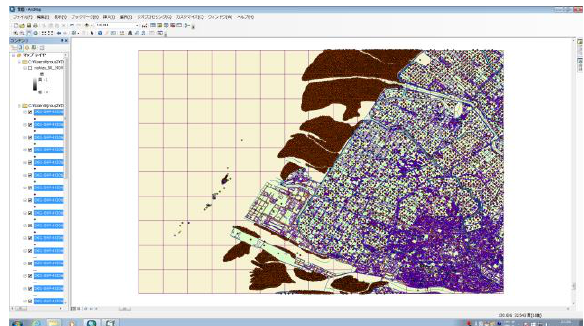
Figure 6. Digital Information by GSI (national large scale map)